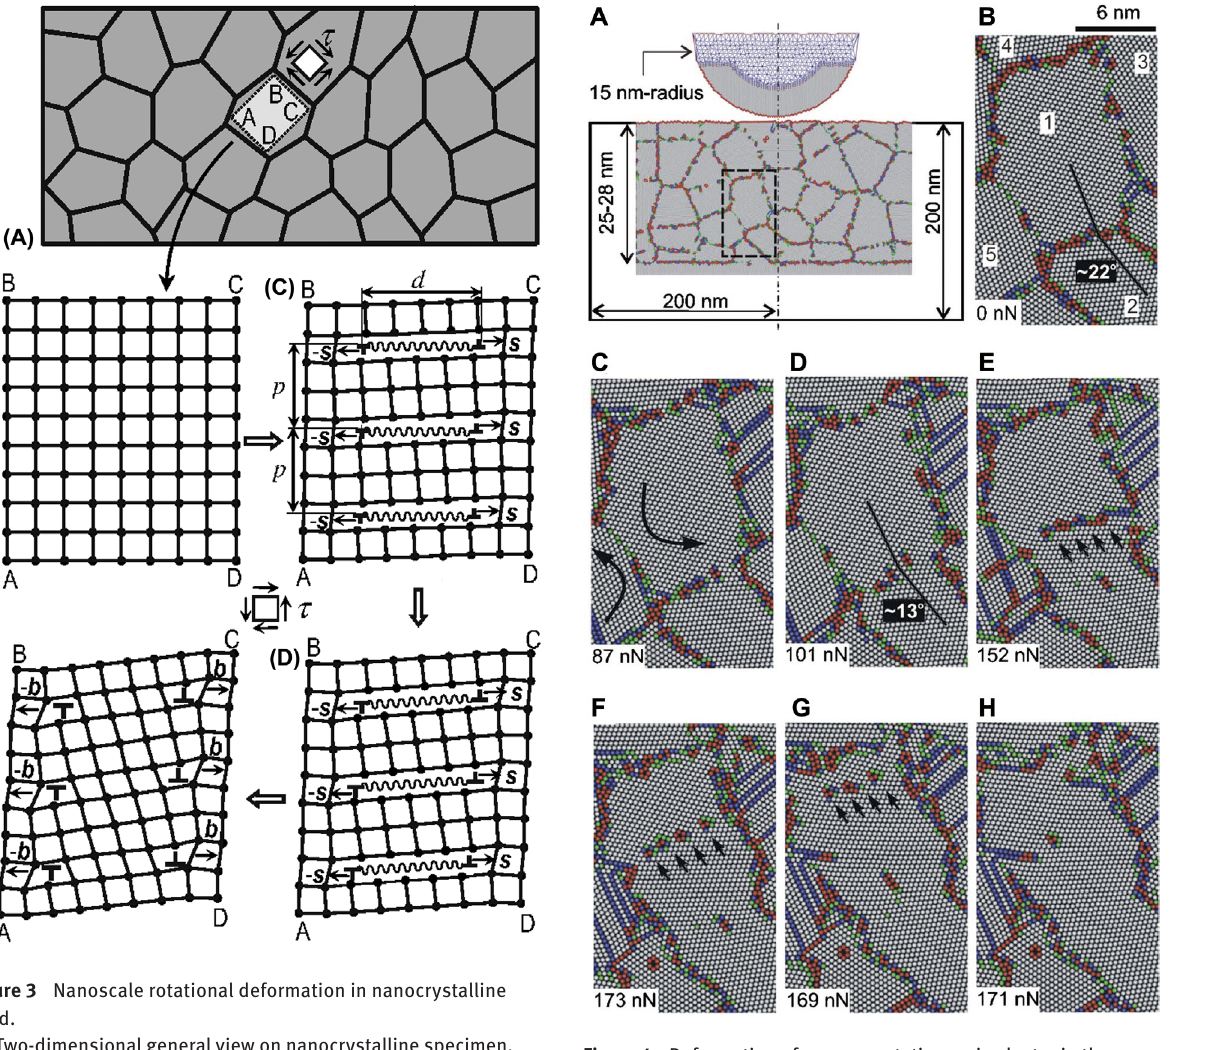
Figure 4 Deformation of a representative grain cluster in the prolongation of a shear band in the 7-nm grain size Al film. (A) Contact zone before indentation. Dimensions and location of the fully refined atomistic region are indicated with respect to the atomistically informed finite element domain (not to scale). Dashed area shows the location of the grain cluster. (B)–(D) Rotation of grain 1. (E)–(H) Motion of the boundary separating grains 1 and 2. The applied contact force is indicated in the lower left corner of the images. Reprinted from [39]. Copyright 2006, with permission from the American Institute of Physics.